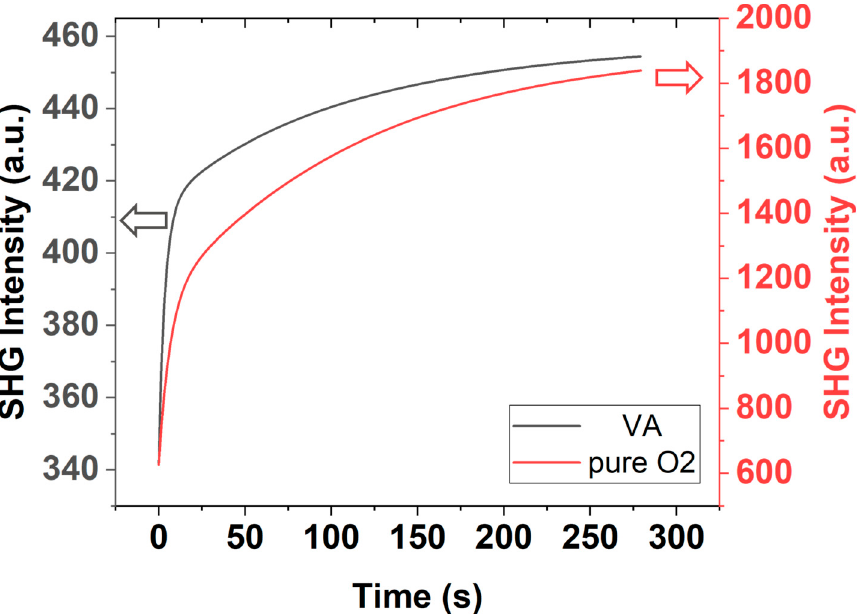
Figure 8. Time-dependent SHG of P1 in a vacuum (left y -axis scale) and pure O 2 gas (right y -axis scale).